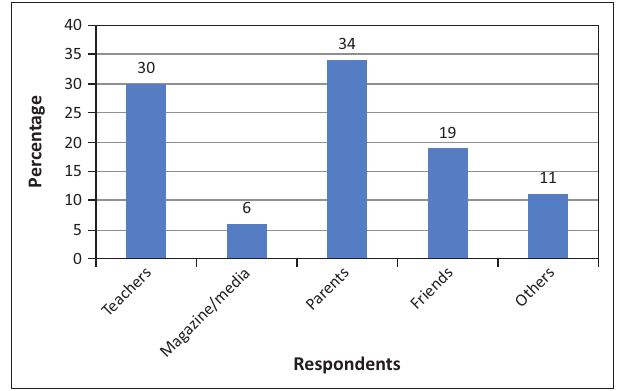
FIGURE 1: Respondents’ source of menstrual